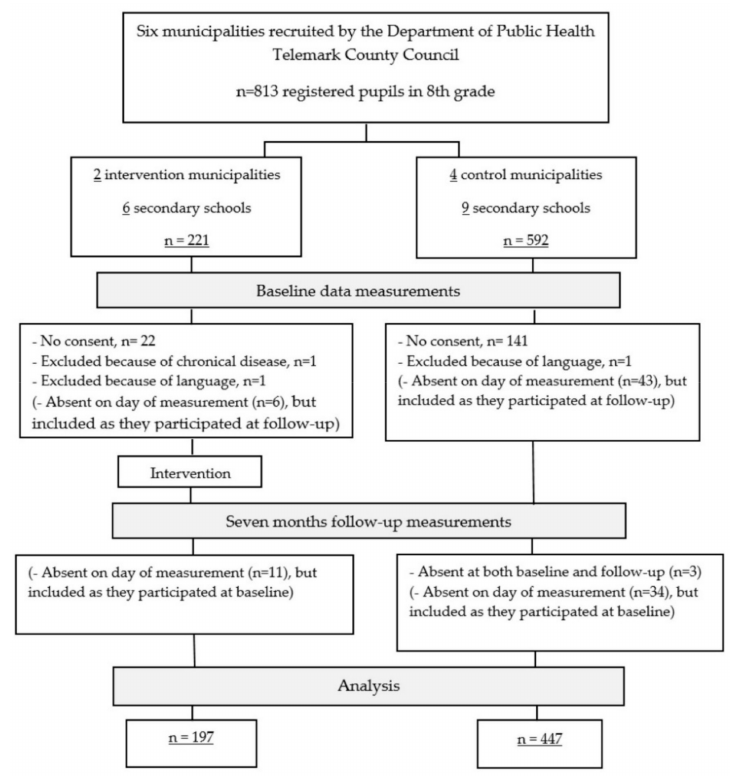
Figure 1. Flow of pupils and study